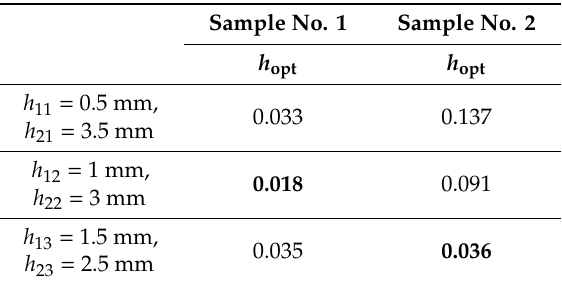
Table 1. h opt values for sample No. 1 and sample No. 2 which are used as a criterion to estimate the depth of